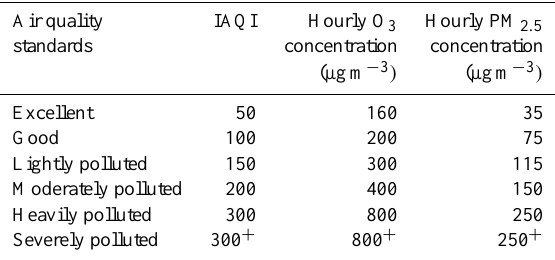
Table 1. Air quality standards, individual air quality indices (IAQI), and their corresponding hourly O 3 and PM 2 . 5 concentration